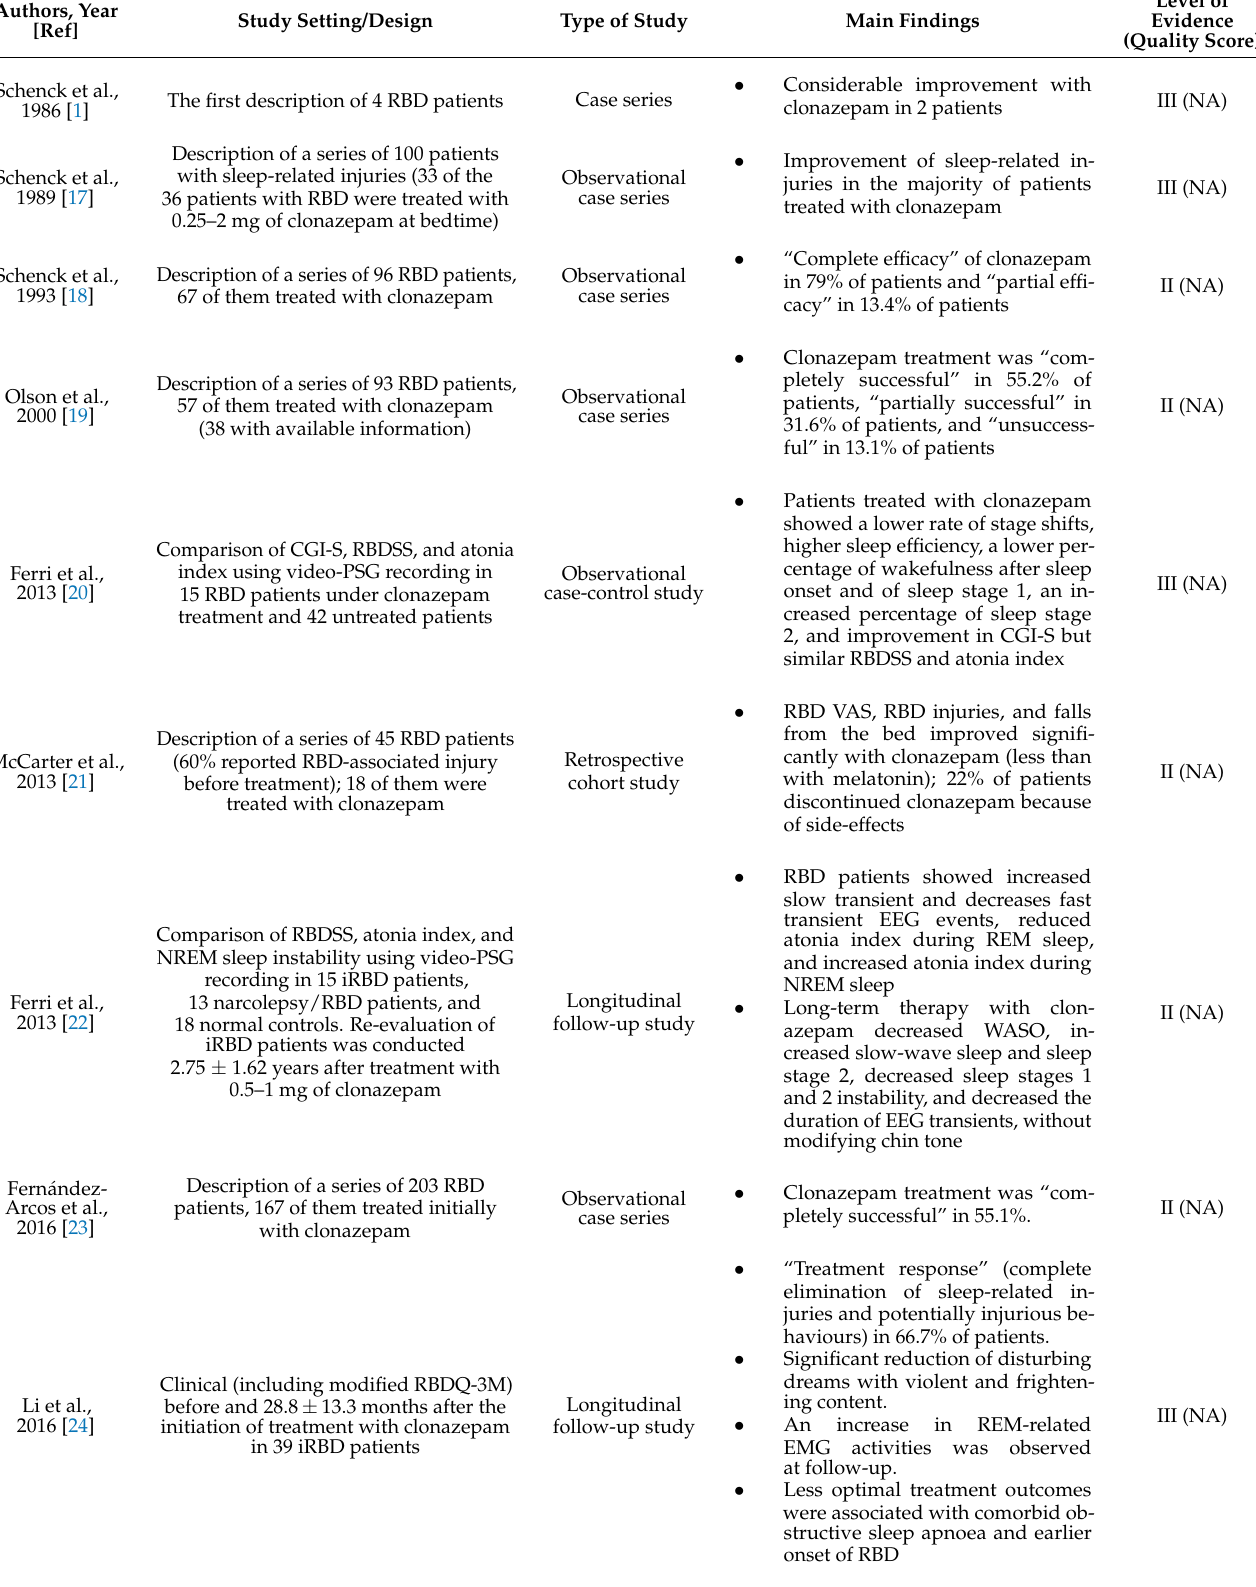
Table 1. Studies describing effects of clonazepam in patients with